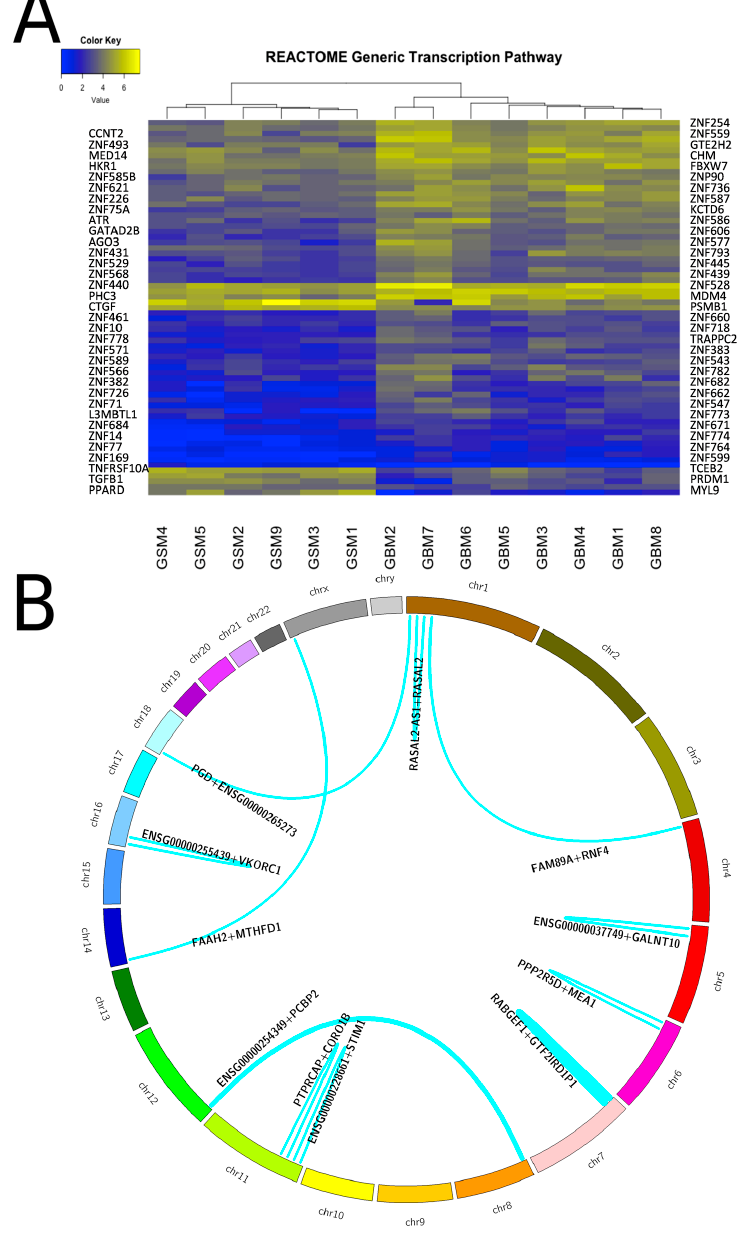
Figure 5. Transcriptomic analyses of gliosarcomas. ( A ). Heatmap of the Generic Transcription Pathway from REACTOME in GBM and gliosarcoma samples. Generic Transcription Pathway was the most significant functional group (defined by gProfiler) represented within genes differentially expressed between gliosarcoma and GBM samples. The heatmap was generated in R using heatmap.2 library with Euclidean distance measure; hierarchical clustering with complete agglomeration has been used. Gene names of odd numbered raws of heatmap is on the right side of the heatmap, while even numbered raws are on left side of the heatmap for better gene names visibility. ( B ) Circos plot of translocations detected in gliosarcoma samples. Line thickness is related to the number of samples detected with that translocation.